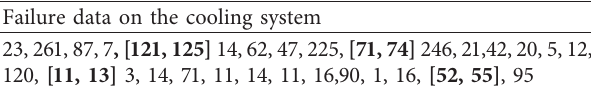
Figure 4: Probability plot of the air condition system failure data. Table 2: Failure time data on the air conditioning system.